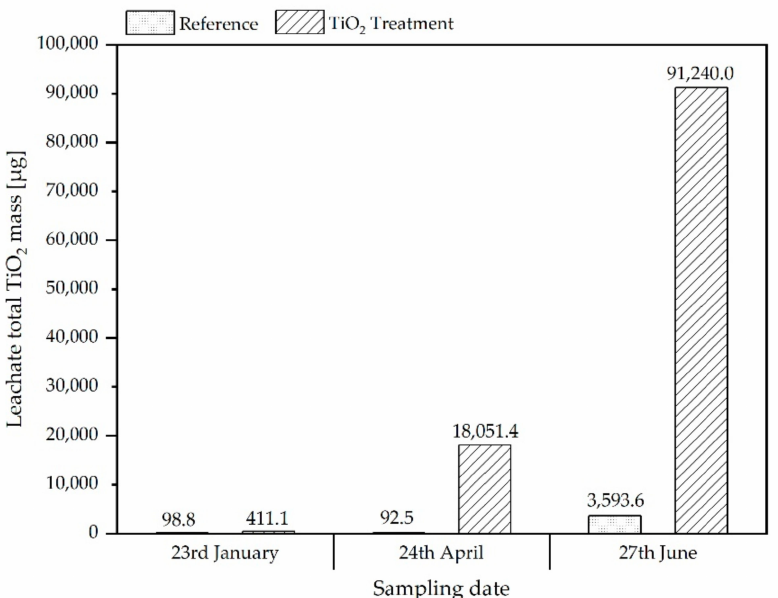
Figure 3. Total TiO 2 content (derived from Ti-concentrations) determined in leachates from pilot scale simulation reactors collected after watering of the soil at end of the respective preceding winter phase.